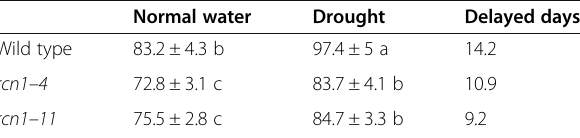
Different letters indicate statistically significant differences ( P <0.05, Duncan multiple-range